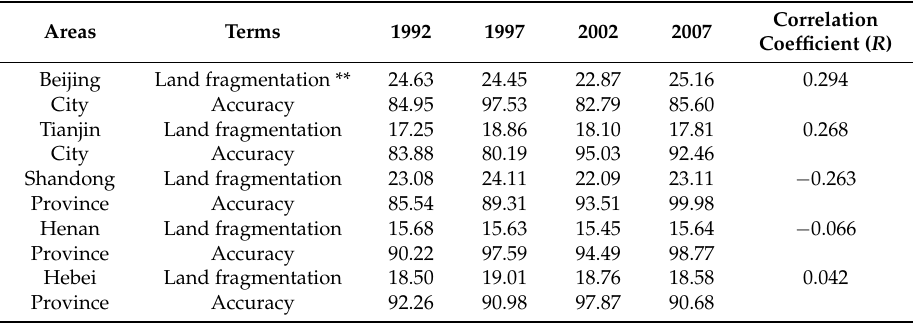
Table 4. The correlation between land fragmentation and accuracy of extracted Multiple Cropping Indices in each subarea from 1992 to 2007.